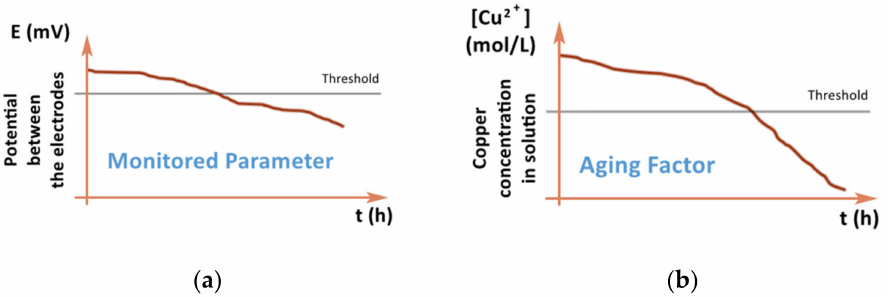
Figure 4. Comparison of the monitored parameter and the investigated parameter [8], ( a ) change of potential between the electrodes (monitored parameter) in time, ( b ) change of copper concentration in the solution (aging factor) in time.